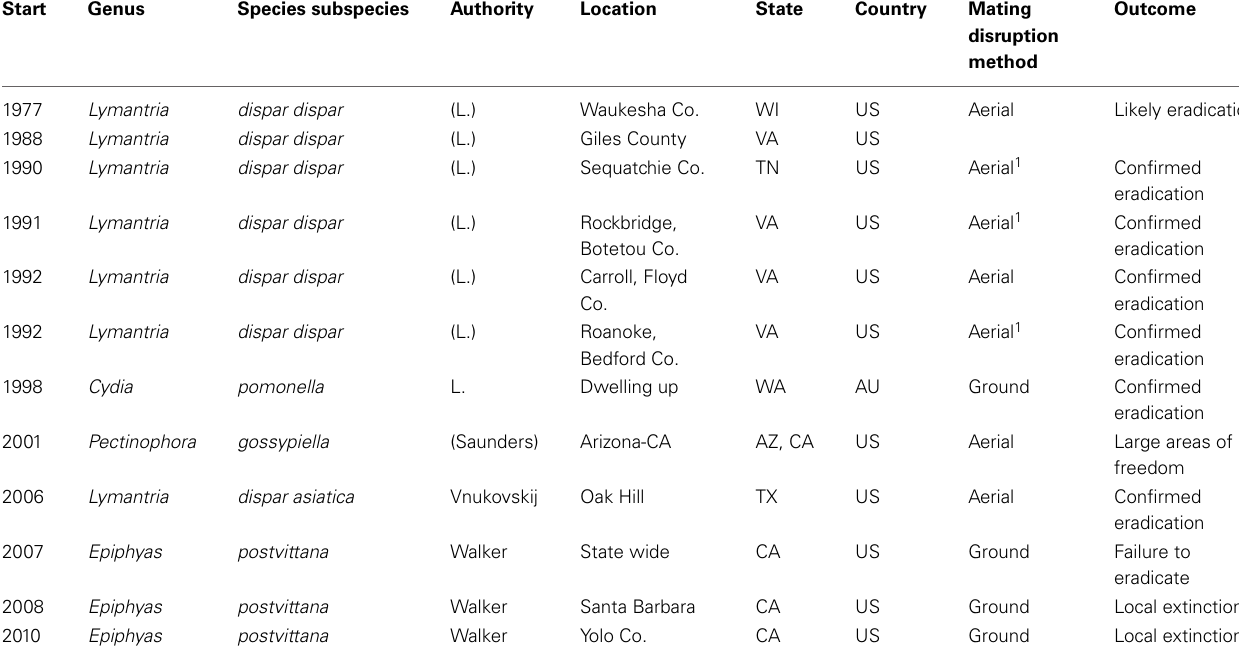
Table 1 | Operational eradication programs of Lepidoptera that have used mating disruption (usually with other tactics) (accessed from Kean et al., 2015; global eradication and response database.